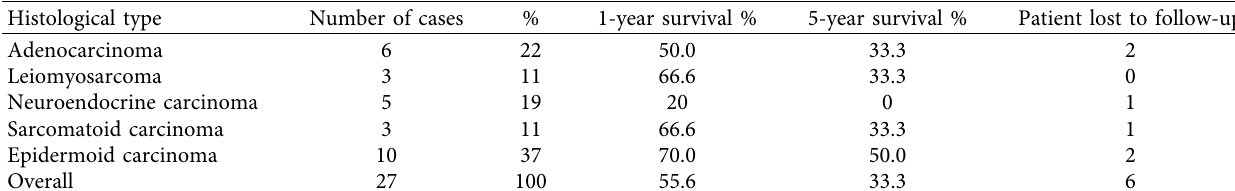
Table 5: Survival depending on tumor histological type at 1 and 5